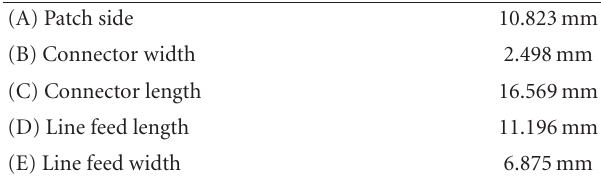
Table 3: The optimized values of the